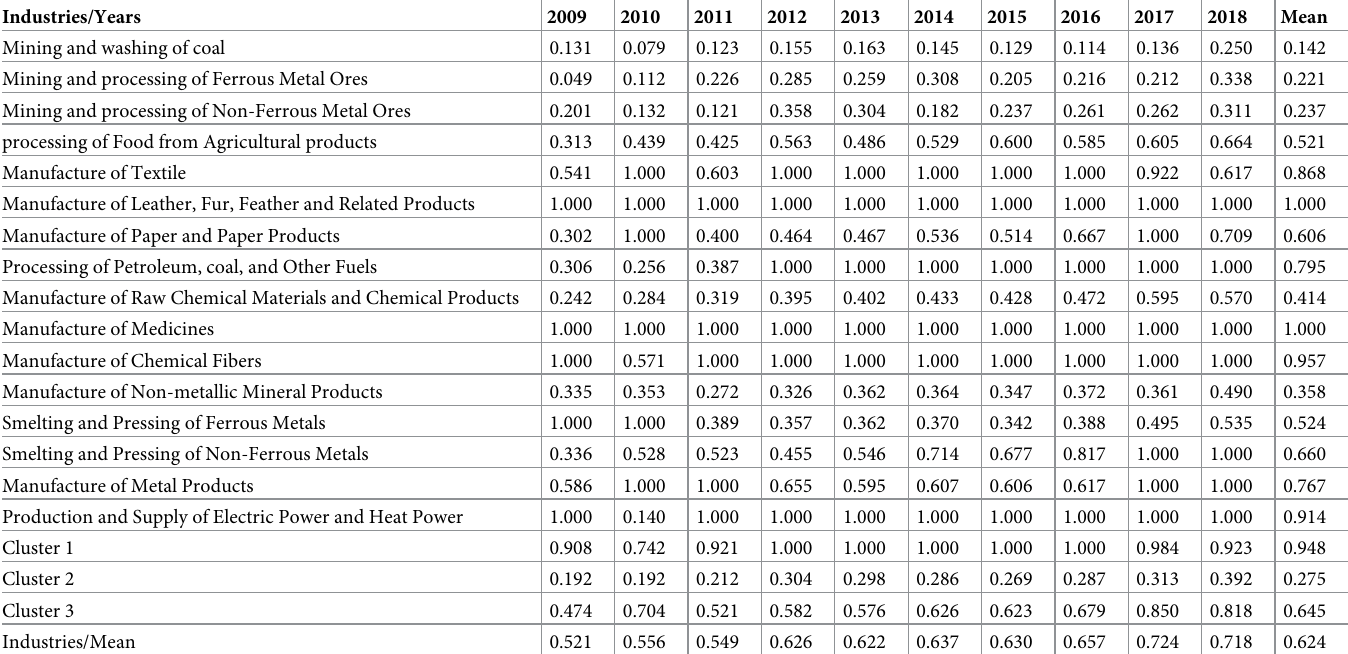
Table 3. Green innovation efficiency of China’s heavy-pollution industries in